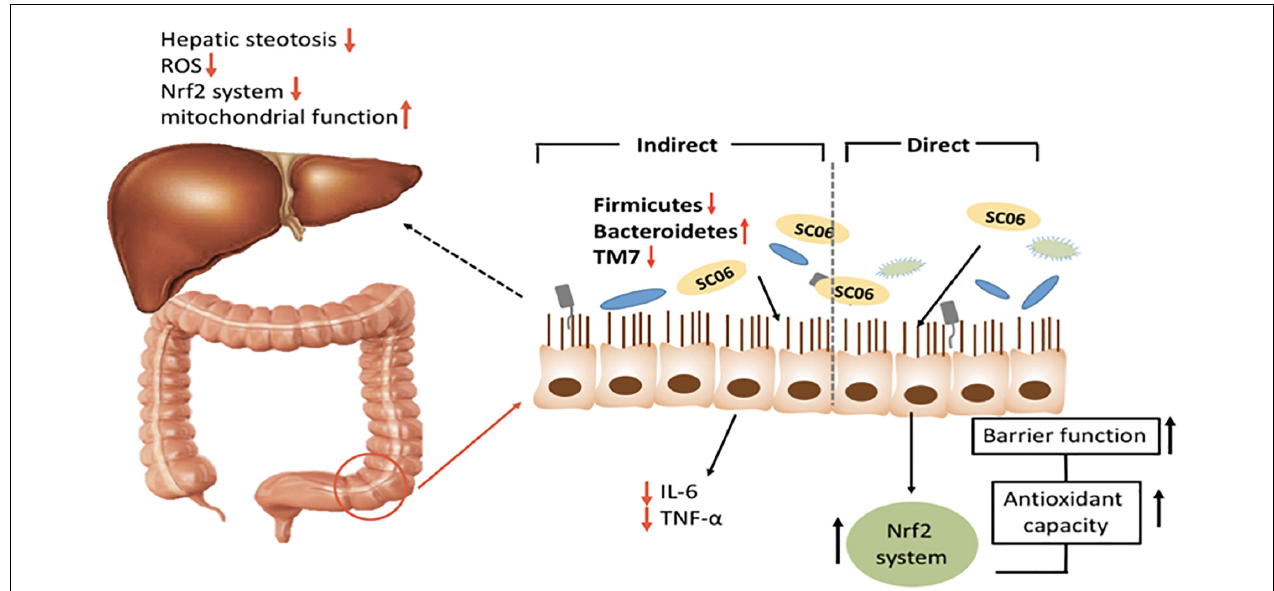
FIGURE 7 | Graphical summary of multiple roles of SC06 in improving HFD-induced obesity and liver